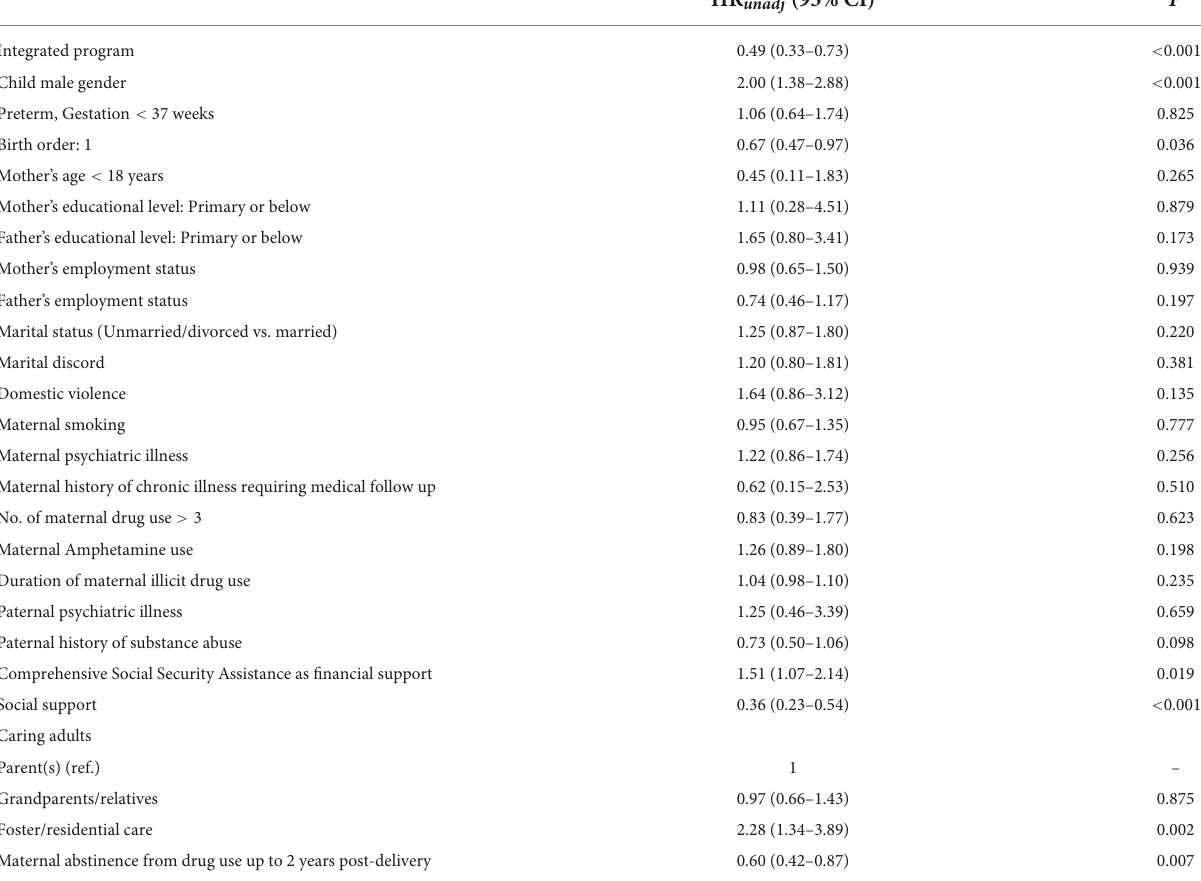
TABLE 3A Factor associated with any developmental delay: Cox regression univariable analysis.